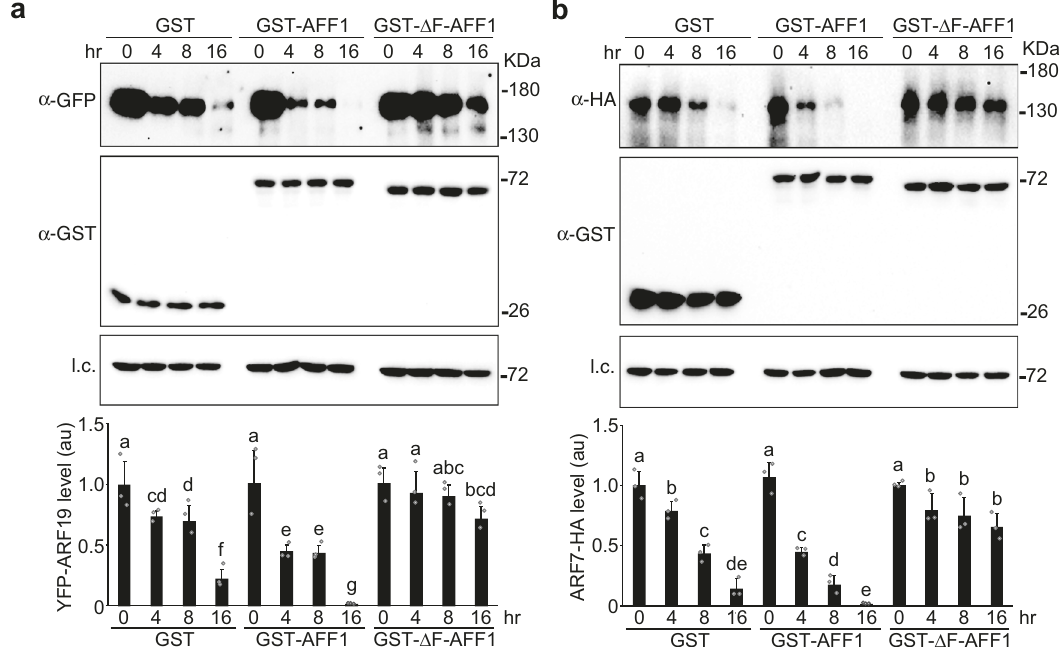
Fig. 4 AFF1 regulates ARF19 and ARF7 protein degradation. a In vitro YFP-ARF19 degradation. Plant lysate from aff1-1 arf19-1 35 S:YFP-ARF19 was incubated with GST, GST-AFF1, or GST- Δ F-box-AFF1 recombinant proteins for the indicated times. Immunoblot analysis (top) and quanti fi cation (bottom) of YFP-ARF19, GST, GST-AFF1, or GST- Δ F-box-AFF1 using the indicated antibodies. Anti-HSC70 used for loading control (l.c.). b In vitro ARF7-HA degradation. Plant lysate from aff1-1 35 S:ARF7-HA was incubated with GST, GST-AFF1, or GST- Δ F-box-AFF1 recombinant proteins for the indicated times. Immunoblot analysis (top) and quanti fi cation (bottom) of ARF7-HA, GST, GST-AFF1, or GST- Δ F-box-AFF1 using the indicated antibodies. Anti-HSC70 used for loading control (l.c.). Data are mean ± SD of three independent experiments. Different letters indicate individual groups for multiple comparisons with signi fi cant differences (one-way ANOVA, Duncan, p < 0.05) and gray dots represent the individual values. The source data in ( a ) and ( b ) are provided as a Source Data fi